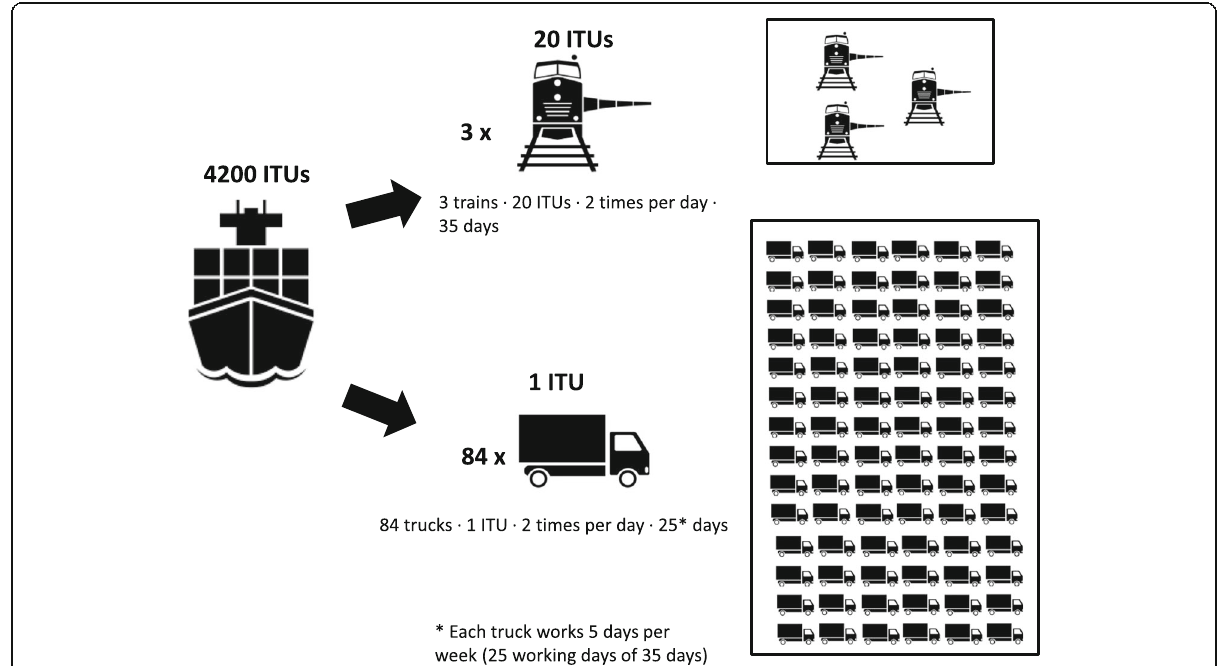
Fig. 17 Comparison of a shuttle train service and a truck fleet service carrying containers from a port to a back port in 35